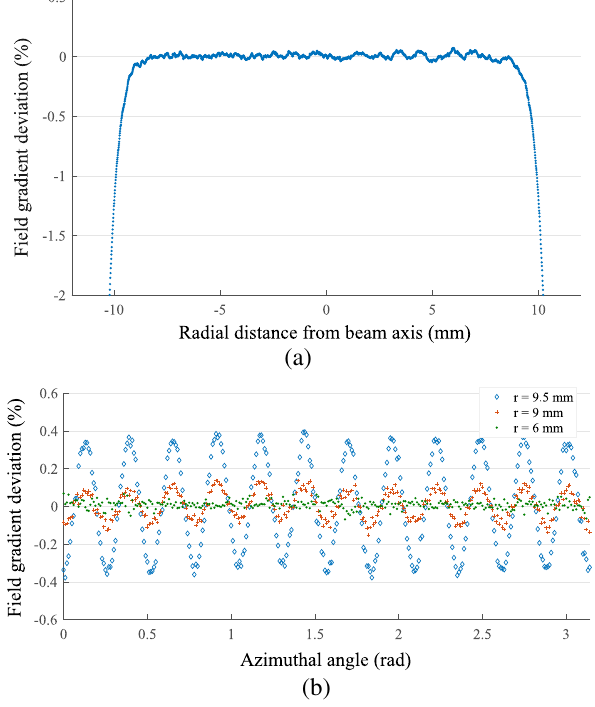
FIG. 18. Field gradient deviation in the concentric design.